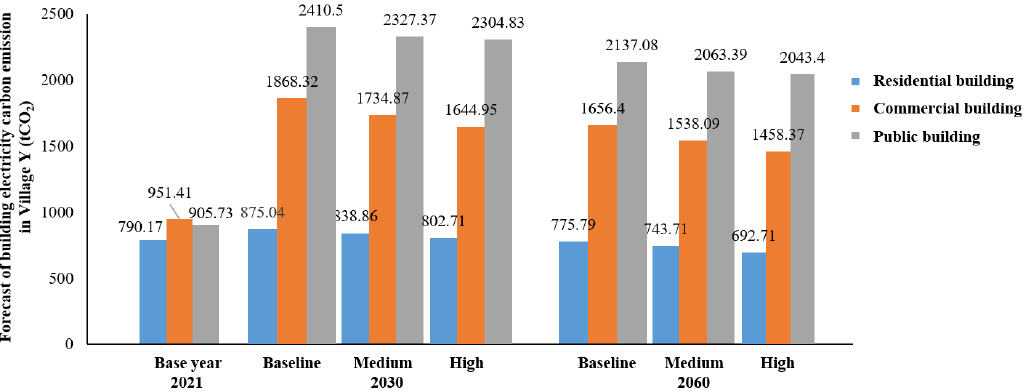
Figure 4. Forecast of building electricity carbon emissions in village Y from 2021 to 2060. Table 6. Total Carbon Emissions forecast of buildings in village Y (Unit: tCO 2